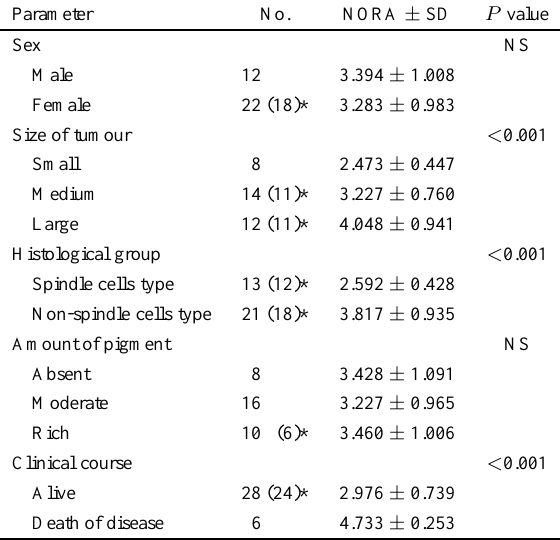
Clinico-pathological data and corresponding mean NORA values ( (cid:22) m 2 ) in choroidal melanomas Parameter No. NORA (cid:6)